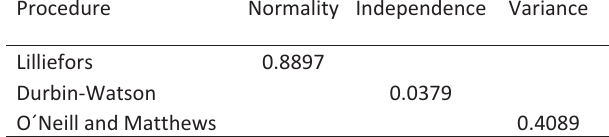
Table 2 ­ p­values of the normality of errors by the Lilliefors test (Lilliefors, 1969), independence of errors by the Durbin­Watson test (Durbin and Watson, 1951) and the homogeneity of variances by the O´Neill and Matthews test (O´Neill and Matthews, 2000)